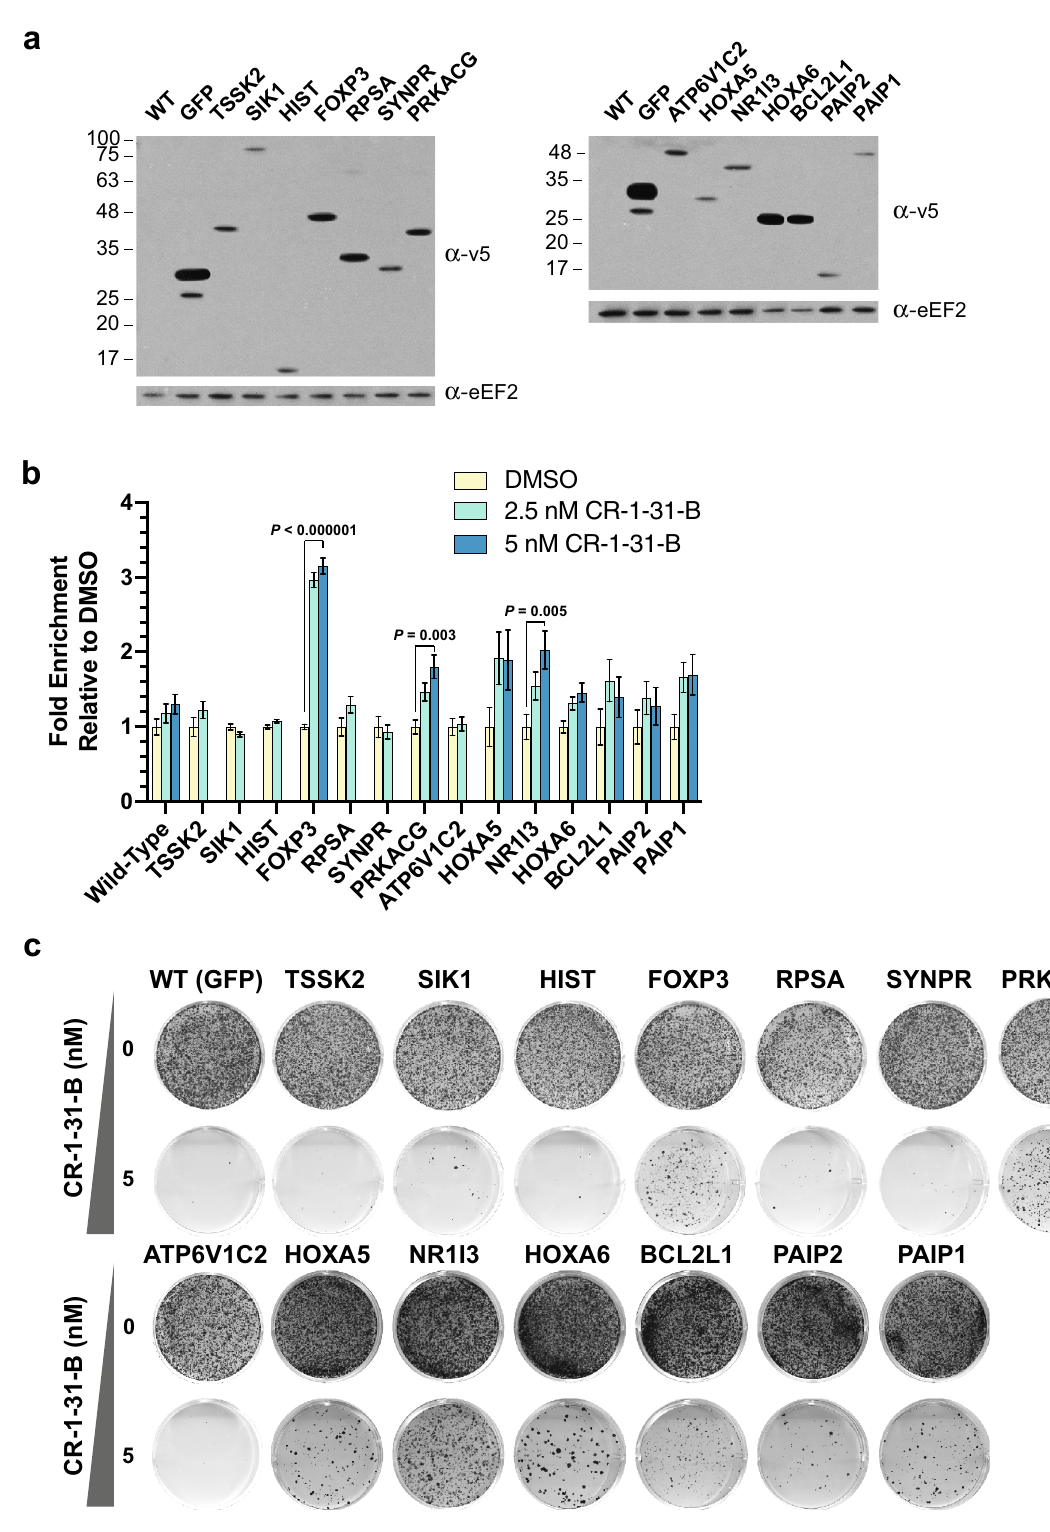
Figure 2. Validation of top candidates for resistance against CR-1-31-B. ( a ) Western blot verifying expression of V5-tagged cDNA constructs transduced into Hap1 cells. Uncropped scans are in Fig. S4. ( b ) Competition assay, wherein negative control, GFP- expressing Hap1 cells were mixed 1:1 with the cell line of interest, and subsequent enrichment of the GFP-negative fraction (cell line of interest) was monitored via flow cytometry following CR-1-31-B treatment (2.5 or 5 nM). Measurements were obtained on day 9 and computed as fold changes over the DMSO-treated condition. For some cell lines, data for 5 nM CR-1-31-B treatment is missing as too few cells survived to reach the event threshold (5000) during acquisition. n = 3 ± SD, statistical significance determined using 2-way ANOVA followed by Dunnett’s multiple comparisons test. The other comparisons in this panel do not fall below 0.05 and were not further considered. ( c ) Representative experiments from colony formation assays in various Hap1 cell lines following CR-1-31-B treatment for 6–14 days are shown. One representative experiment from at least three biological replicates is